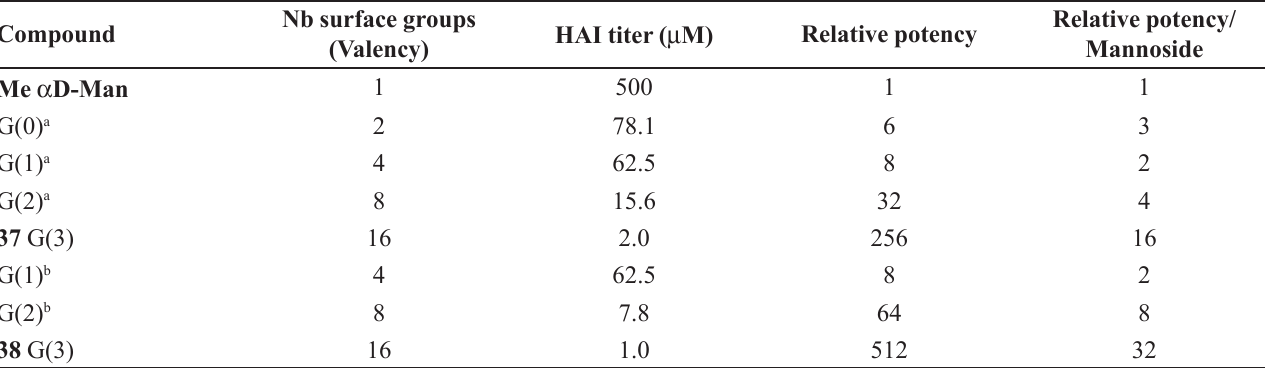
TABLE II - Relative inhibitory properties of the two series of mannosylated glycodendrimers measured by the hemagglutination titer (HAI) against guinea pig erythrocytes and fimbriated uropathogenic E. coli BW25113 Compound